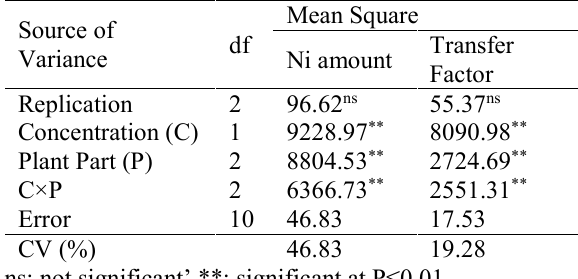
Table 1. Analysis of variance for nickel accumulation in wheat